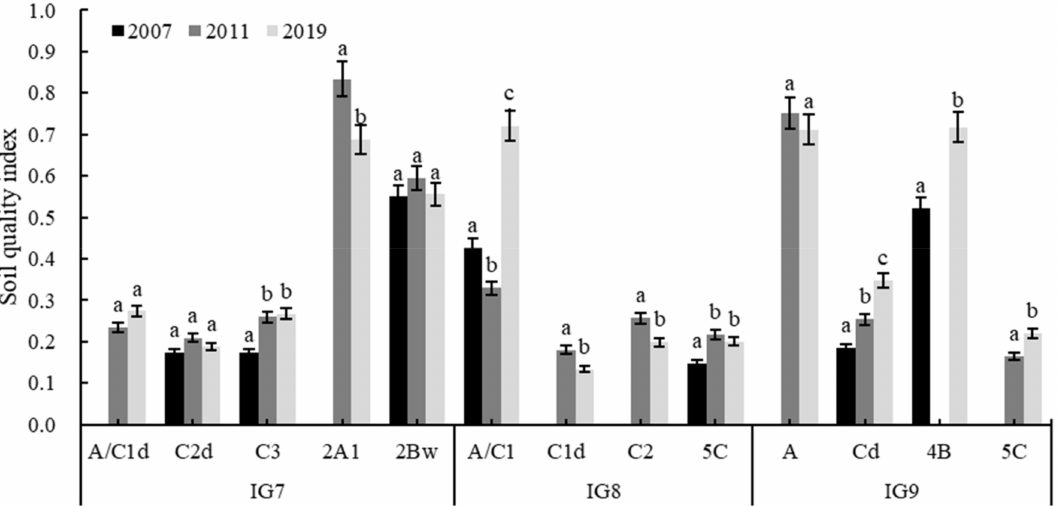
Figure 4. Soil quality index at different sites; different letters express significant difference at the same soil horizon (one-way ANOVA, p < 0.05).